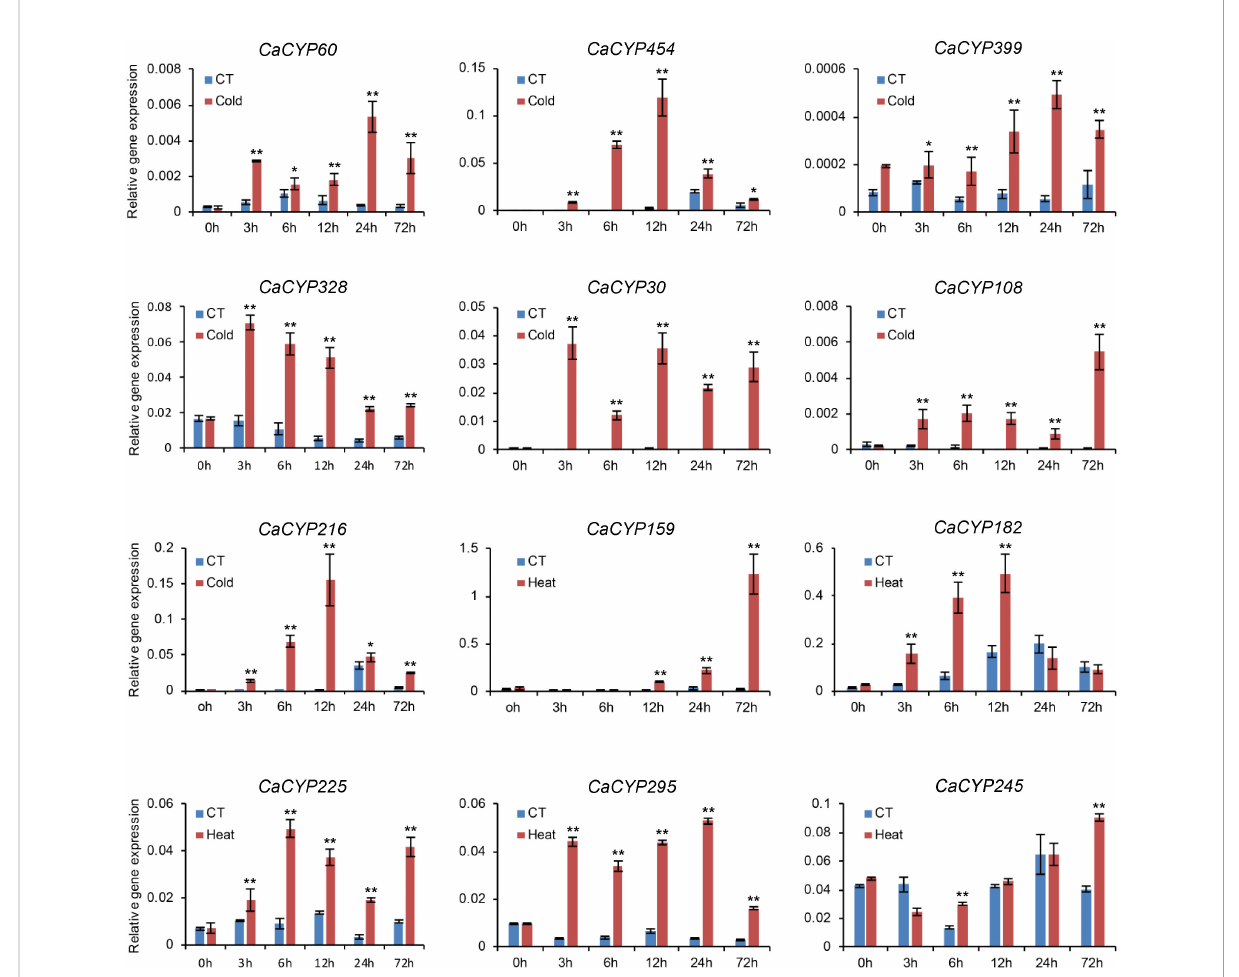
FIGURE 7 qRT-PCR analysis of the CaCYP gene expression under cold and heat stress. Leaves were picked up at 0, 3, 6, 12, 24, and 72 h after 10°C cold and 40°C heat treatments. Data represent the mean ± SD of three independent experiments. An asterisk on the bars indicates a signi fi cant difference by t -test. ** P ≤ 0.01, * P ≤ 0.05 in t